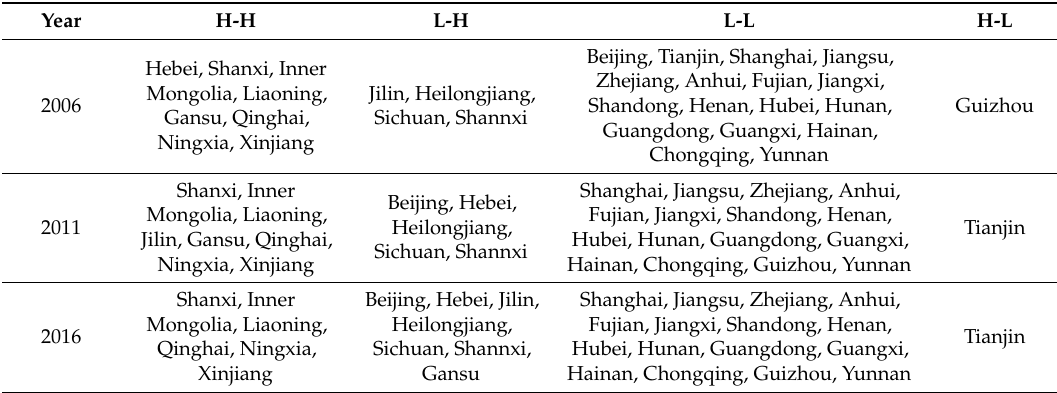
Table 4. Local agglomeration of China’s EIWB in 2006, 2011 and 2016.